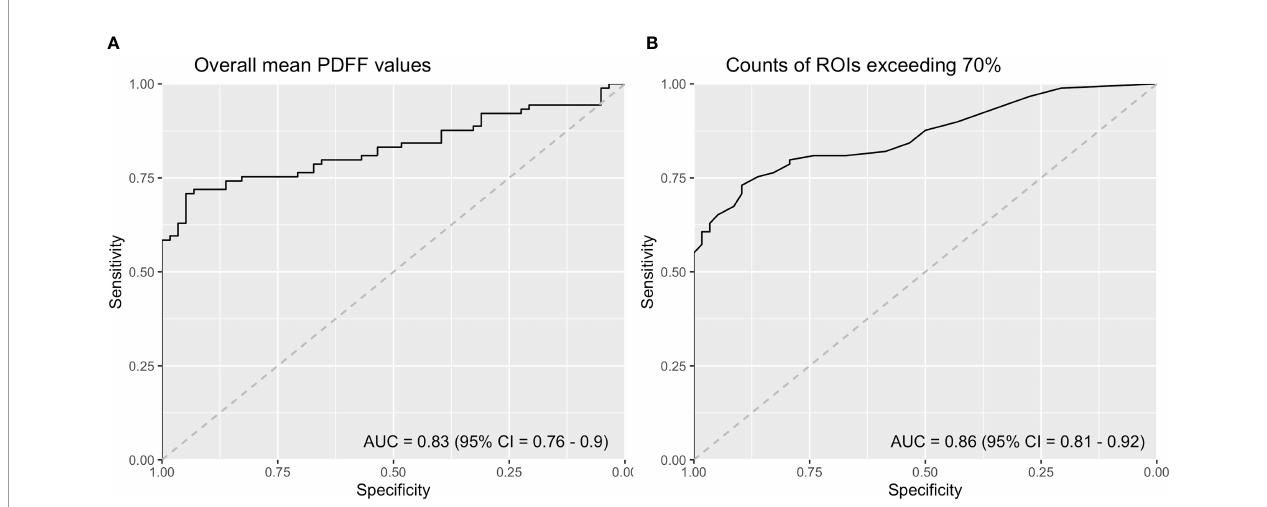
FIGURE 4 | ROC curve analysis of (A) Overall mean PDFF values in the SIJs (B) Counts of ROIs with PDFF values exceeding 70% (ROI, region of interest; PDFF, proton density fat